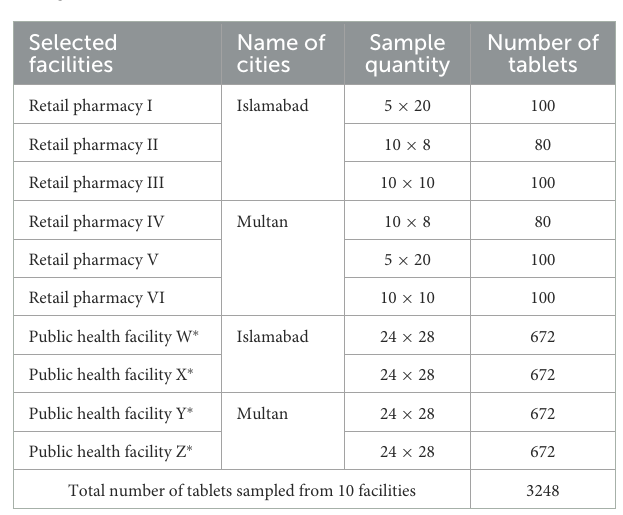
TABLE 1 Selected facilities and number of samples collected from each facility in different cities of